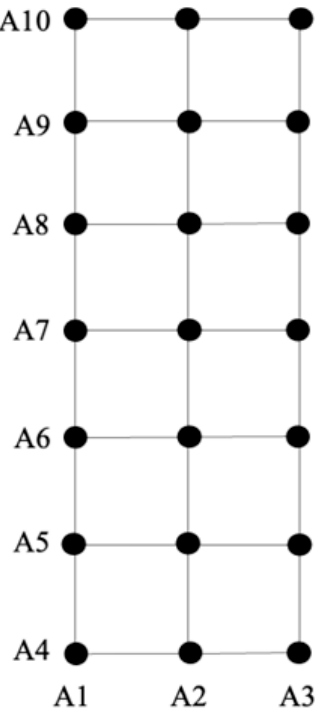
Figure 3. Indirect tests grid configuration. Figure 3 . Indirect tests grid configuration .